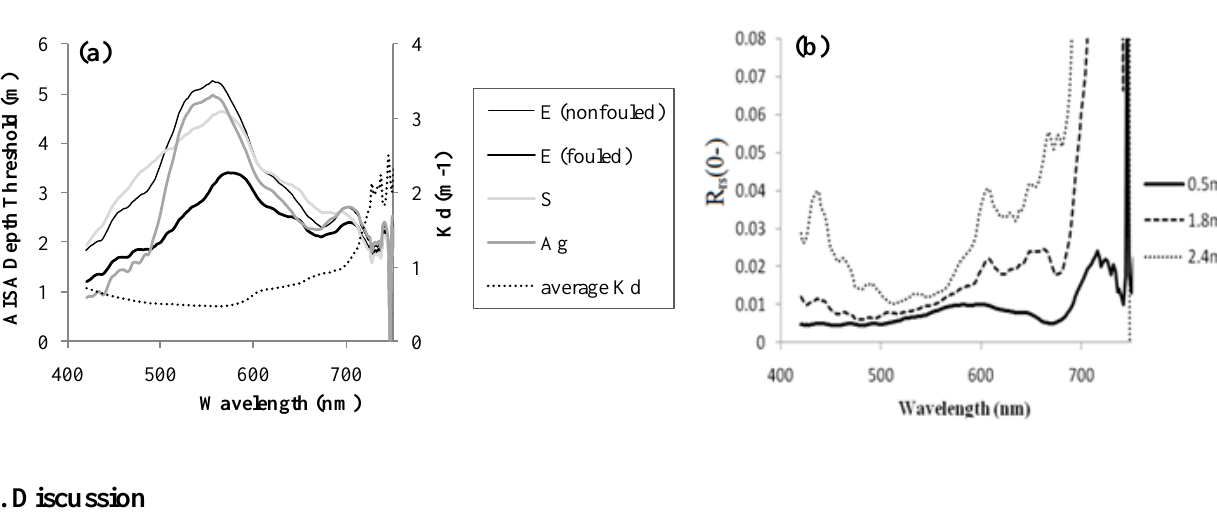
Figure 7. (a) Depth restriction at which the AISA sensor can no longer distinguish between each substrate and deep water (solid lines) and average Kd value for the scene (dotted line) derived from in situ in water spectral profiles. Depth restriction is wavelength dependent and varies inversely with K . (b) Spectra of medium density eelgrass beds with epiphytes at d varying depths extracted from the Maritorena water column corrected AISA image